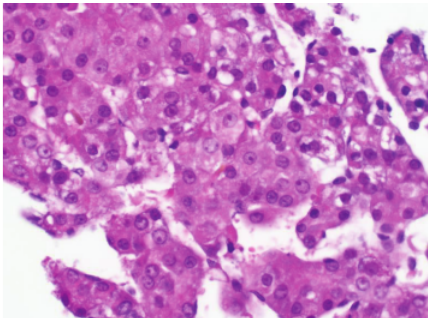
Figure 2: Hematoxylin- and eosin-stained section of a CT-guided core biopsy of the liver lesion shows well-differentiated to moder- ately differentiated hepatocellular carcinoma in a trabecular pattern (40x magnification).